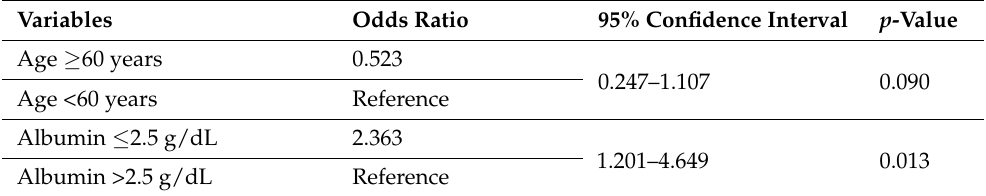
Table 5. Multivariate analysis of association between variables and DIC development in septic patients